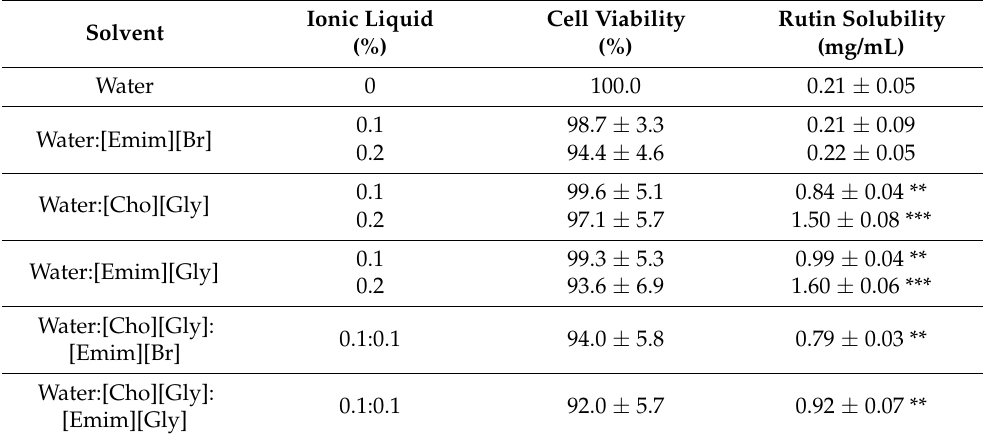
Table 2. Cell viability of HaCaT cells exposed to [Emim][Br], [Cho][Gly], [Emim][Gly] (0.1 or 0.2% v / v ; 24 h), and [Cho][Gly]:[Emim][Br] and [Cho][Gly]:[Emim][Gly] (0.1:01% v / v , 24 h) evaluated by MTT assay ( n = 3, mean ± SD, expressed as percentages of the non-treated control cells). Results from rutin’s solubility studies at 25 ± 2 ◦ C in water, in water:IL mixtures, and in water:IL:IL combinations are also presented ( n = 3, mean ± SD, ** p < 0.01, *** p < 0.001). Ionic Liquid Cell Viability Rutin Solubility Solvent (%) (%)